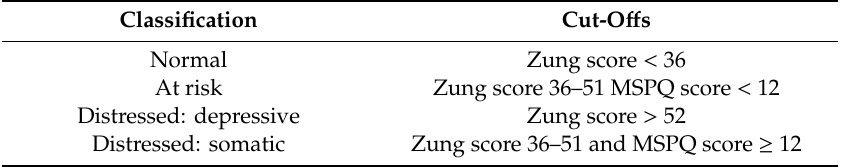
Table 1. The Distress Risk Assessment Method (DRAM): classification of patients according to the scores obtained on the Modified Somatic Perception Questionnaire (MSPQ) and Zung Depression